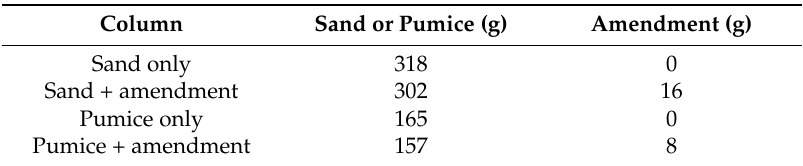
Table 2. The amount of geomedia used for column packing with and without carbon amendment (5% by weight). Column Sand or Pumice (g) Amendment (g) Sand only 318 0 Sand + amendment 302 16 Pumice only 165 0 Pumice + amendment 157 8